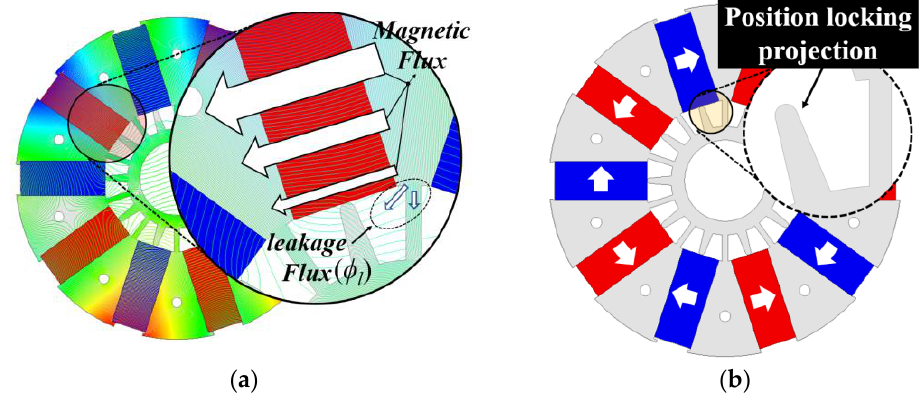
Figure 5. Factors that decrease magnetization performance. ( a ) Reduced flux inside the rotor and leakage flux to back yoke, ( b ) Position locking of projection in the rotor.